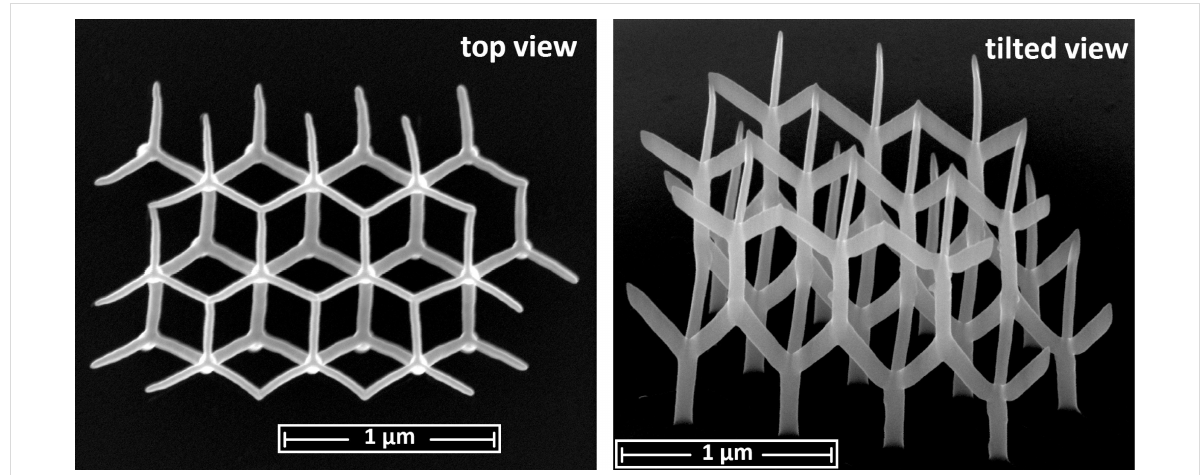
Figure 11: Array of trees, each consisting of a root and three branches. The roots of the trees of the second level rest on two or three connected branches of the first level. The total deposition time was 12:58 minutes. Precursor: HCo 3 Fe(CO) 12 , high-resolution mode, beam current: 13 pA. Figure first published in [25].